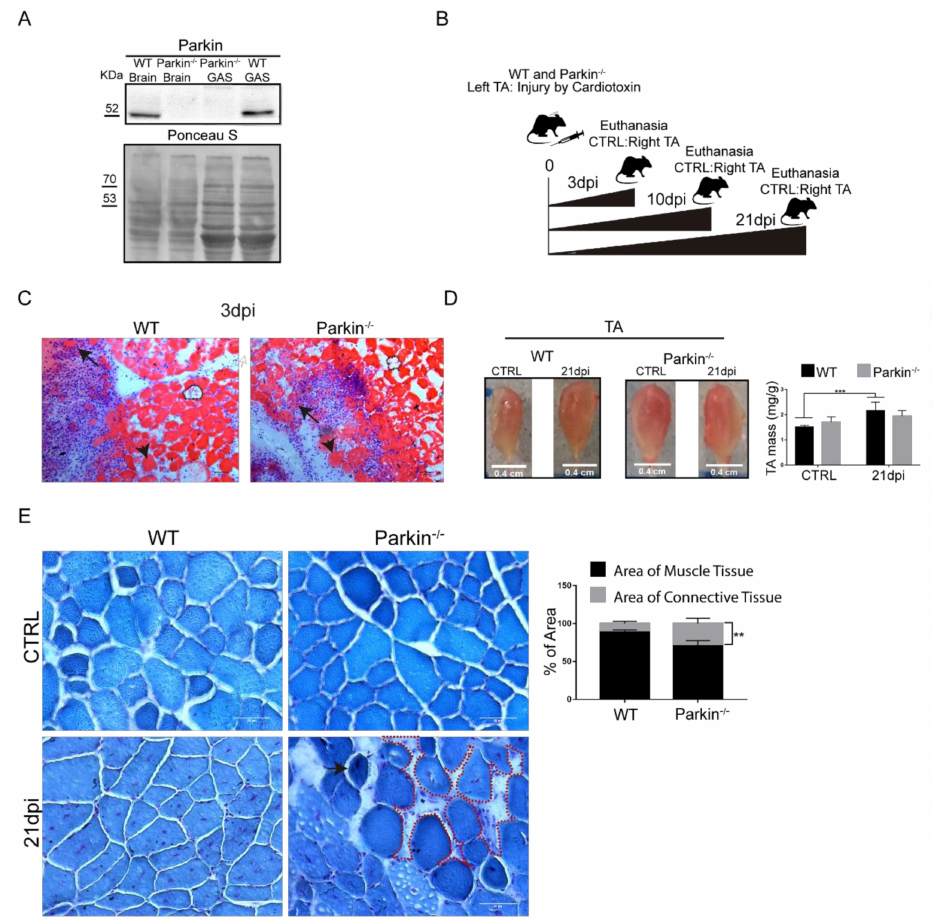
Figure 3. Absence of Parkin impairs skeletal muscle plasticity during the regenerative process. ( A ) Western Blot of Parkin in Gastrocnemius (GAS) muscle and brain from Parkin − / − mice. ( B ) Experimental design for evaluating the regenerative process in mice. ( C ) Confirmation of injury during inflammatory phase by hematoxylin and eosin staining of TA muscle from WT and Parkin − / − mice at 3dpi. Black arrows denote necrotic fibers, arrow heads mark hypercontracted fibers, and dotted areas outline ghost fibers. The images were acquired with a 20 × objective. Bars represent 50 µ m. ( D ) Representative images of CTRL and 21dpi of TA muscle from WT and Parkin − / − mice. Graph show TA weight (mg) / Body weight (g) ratio. Data represent means ± SD (two-way ANOVA: Interaction p = 0.0285; Row Factor, injury Factor, p < 0.0001; Column Factor, genotype Factor, p = 0.9023; Bonferroni’s multiple comparisons test *** p < 0.01; n = 5). ( E ) Gomori staining of cryosections of CTRL and at 21dpi TA muscle from WT and Parkin − / − mice. The dotted area indicates accumulation of connective tissue and black arrow indicate hypercontracted fiber in Parkin − / − mice. Bar graphs show % of area occupied by muscle tissue and connective tissue in TA muscle from WT and Parkin − / − mice at 21dpi. Data represent means ± SD t -test: ** p < 0.01; n = 5). The images were acquired with a 40 × objective. Bars represent 50 µ